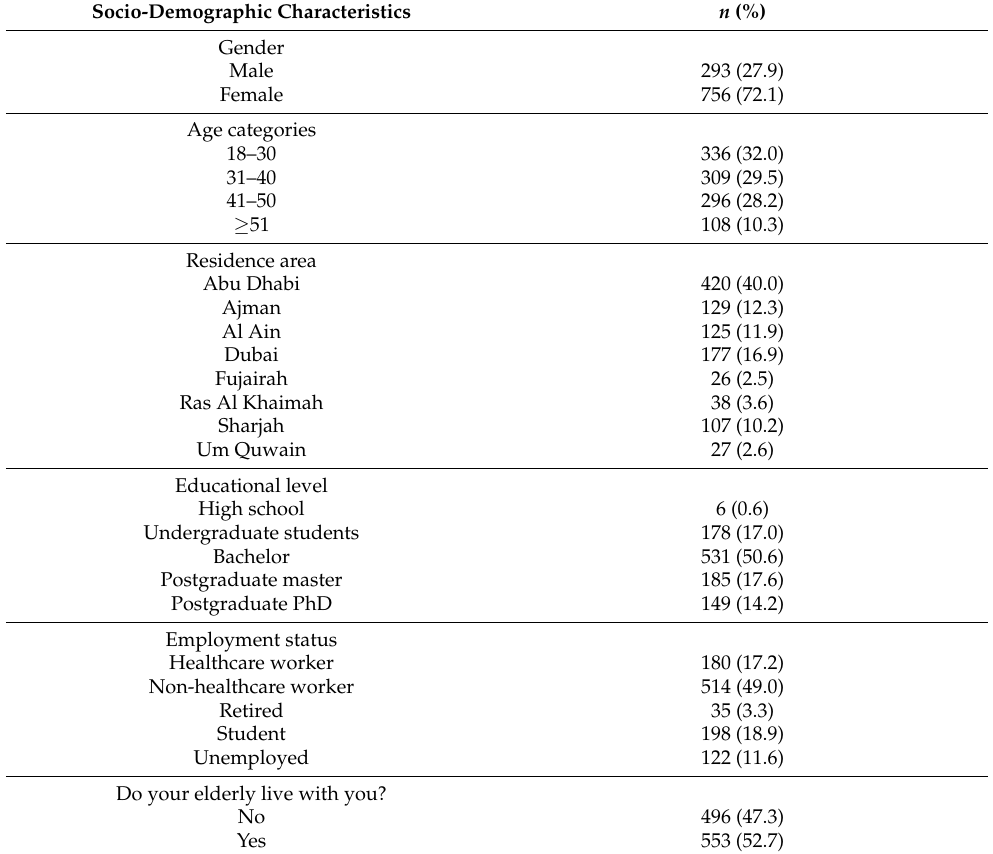
Table 1. Patients’ characteristics ( n =